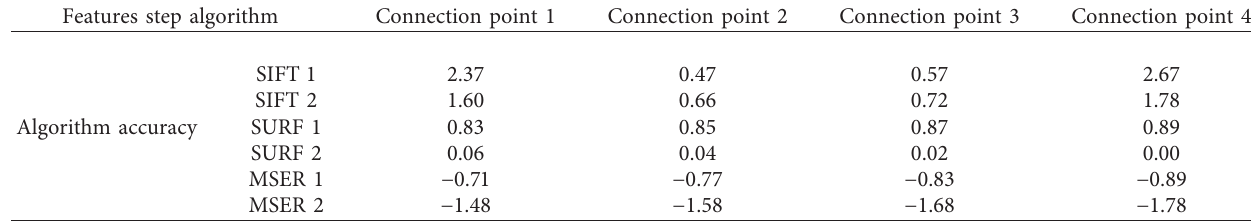
Table 2: UAV low-altitude photometric system.